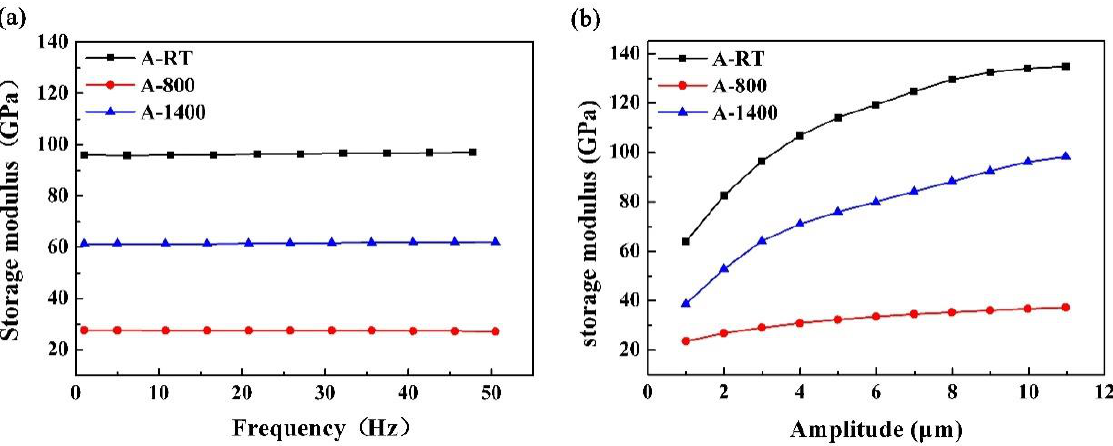
Figure 7. Plots of the storage modulus of the composites versus frequency ( a ) and amplitude ( b ).